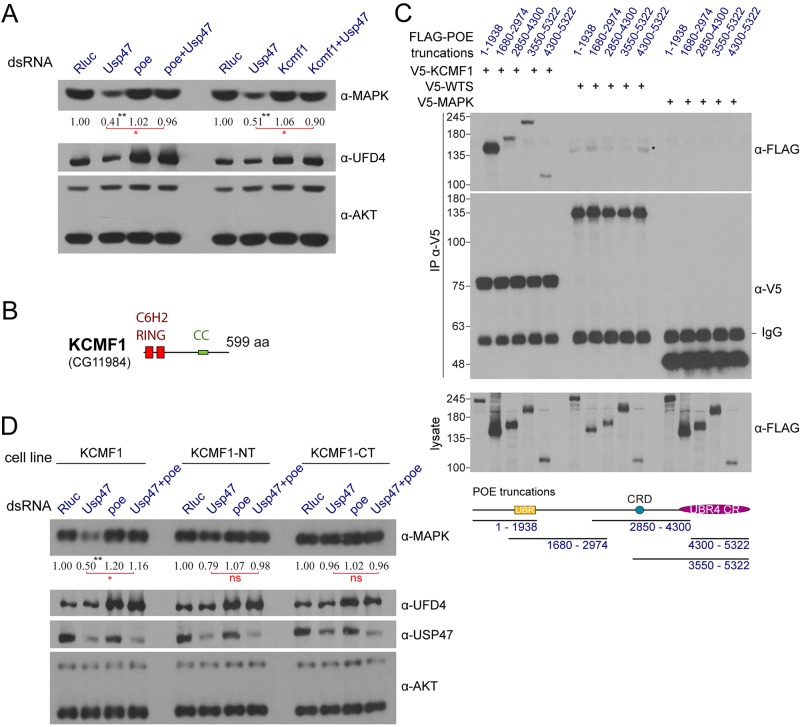
The E3 ligase Kcmf1 also rescues Usp47 dsRNA and interacts with poe.(A) Western blot displaying that co-depletion of the E3 ligase Kcmf1 (CG11984) restores MAPK level reduction induced by Usp47 dsRNA. The impact is similar to that of poe co-depletion. Notably, Ufd4 levels are seen to increase upon poe depletion, and this is also observed upon Kcmf1 depletion (validated by qPCR in S5 Table). (B) Schematic representation of the KCMF1 protein product with the amino acid length and positions of the C6H2-type RING domain (“really interesting new gene”) and predicted coiled-coil region (CC). The C6H2 RING domain is an uncommon zinc-finger subclass that is present in a restricted set of proteins [44] and bears some resemblance to the zinc finger domain of MetAP1 methionine aminopeptidase [45]. (C) Different FLAG-tagged portions of POE (presented in the schematic below the blot with their respective amino acids (a.a.) positions) were expressed in S2 cells and tested for interaction with V5-tagged KCMF1, WTS, and MAPK by immunoprecipitation followed by western blotting. WTS, a member of the HPO (hippo) pathway, was used as a negative control. Both truncations containing the UBR4 Conserved Region (UBR4 CR) as well as one truncation comprising the UBR domain and part of POE’s mid region were detected in the KCMF1 IP. By comparison, no interaction was observed between POE and MAPK, while only a faint non-specific band (marked with an asterisk) was observed in the WTS IP. The IgG heavy chain position is also indicated on the α-V5 IP blot. (D) S2 cell lines stably expressing V5-tagged KCMF1 (a.a. 1–599), KCMF1 N-terminal (KCMF1-NT; a.a. position 1 to 239), and C-terminal (KCMF1-CT; a.a. position 241 to 599). KCMF1-NT and CT act as dominant negative proteins and partially rescue MAPK levels following Usp47 depletion compared to WT KCMF1. KCMF1-NT had a slightly weaker rescue effect than KCMF1-CT. The cell lines were probed by immunoblot following treatment with the indicated dsRNAs. (A and D) Densitometry quantifications are provided for MAPK levels (normalized to the AKT loading controls). All experiments were performed in triplicate or more, and p-values were calculated (paired two-tailed Student’s t test) comparing values to the Rluc control (*: p < 0.05; **: p < 0.01). t tests performed on other samples are shown in red. “ns” denotes not significant. Raw data for (A and D) can be found in S1 Data.